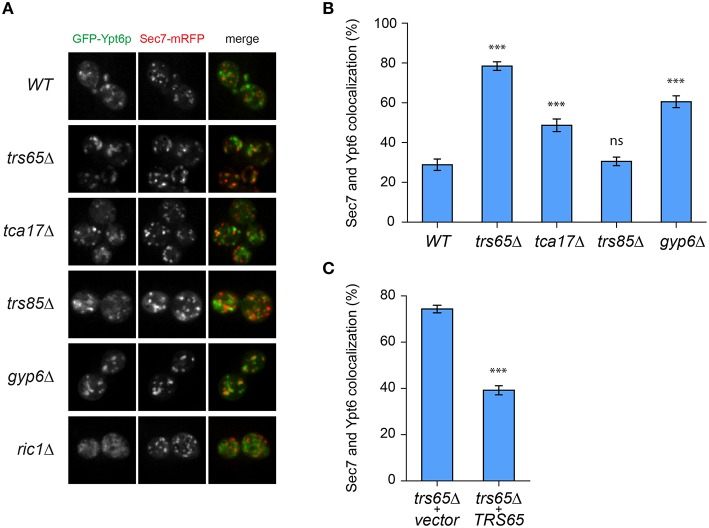
GFP-Ypt6p becomes enriched at the late Golgi in a trs65Δ mutant. (A) The localization of GFP-Ypt6p was examined in different strain backgrounds and compared to Sec7-mRFP localization, a late Golgi marker. A representative field of 1–2 cells is shown for each strain background. (B) The percentage of GFP-Ypt6p punctae co-localizing with Sec7p-mRFP was quantified in each strain. Significance was assessed between wild type and each mutant using a one way ANOVA. Post-hoc differences were made using Fisher's probability of least squared differences. P-values are indicated by asterisks (*** ≤ 0.001). (C) Co-localization of GFP-Ypt6p and Sec7p-RFP was quantified in a trs65Δ strain transformed with either empty vector (vector) or wild type TRS65. Significance was assessed as indicated in (B). For (B,C), 56–96 cells, representing 10–15 fields with 3–10 cells each were counted for each strain. Error bars represent standard error of the mean (SEM). Significance in (B) was assessed using an unpaired t-test. P-values are indicated by asterisks (*** ≤ 0.001).